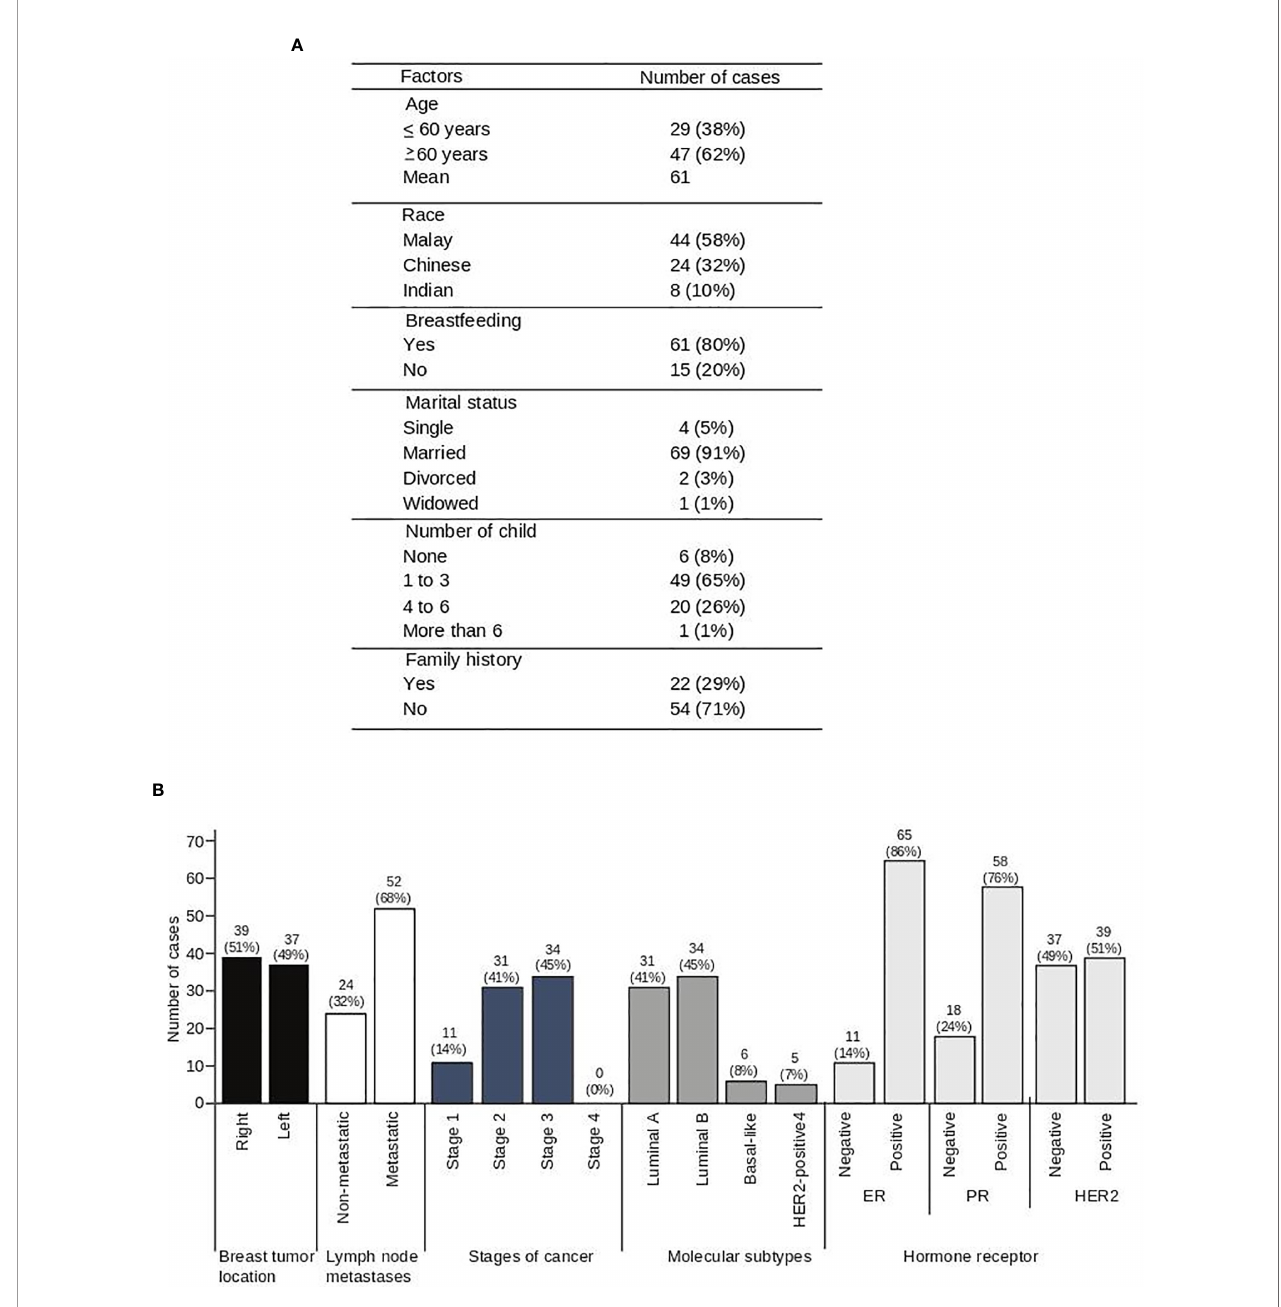
FIGURE 1 | Socio-demographic data of 76 breast cancer patients. Demographic data (A) and clinical characteristics (B) of breast cancer